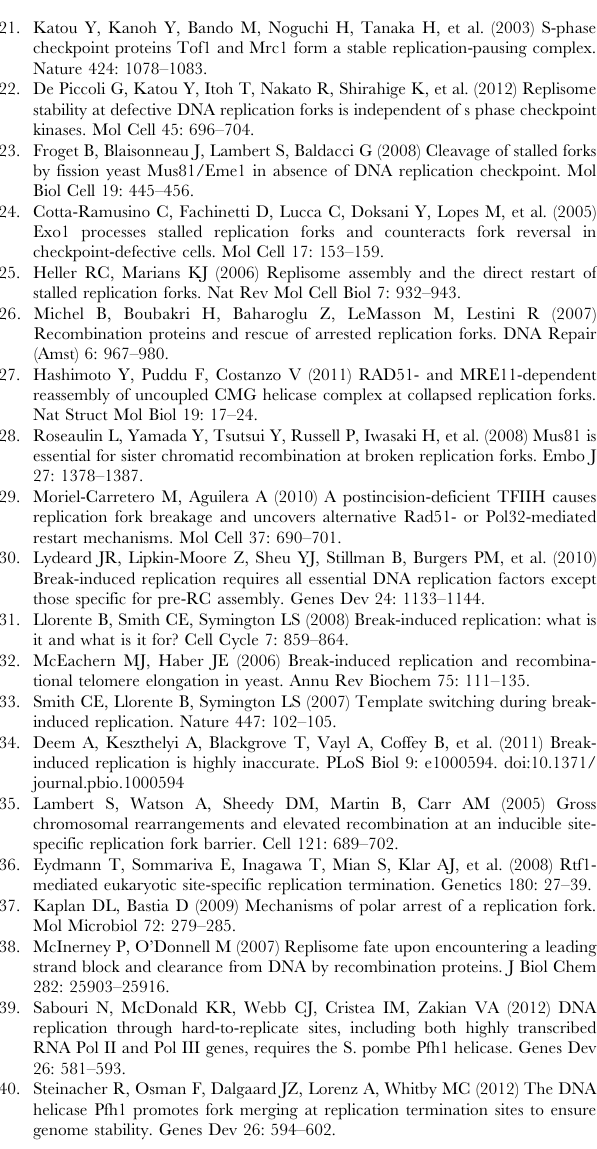
Figure S3 Features of replication slippage induced by fork arrest. A. Table of deletion/duplication and micro-homology features. B. Map of deletion and duplication events observed within the ura4 ORF in the t-ura4 , ori construct upon fork arrest. Del and Dup stand for deletion and duplication, respectively. Figure S4 Sensitivity of rad22-d strain to acute exposure to 20 mM of HU or 20 m M of CPT. The values reported are means of two to four independent experiments. Error bars indicate the standard error of the mean (SEM). Figure S5 Fork-arrest-induced replication slippage is indepen- dent of the post-replication repair and mismatch repair. A–C. Left panels: Serial tenfold-dilutions of indicated strains cultured in thiamine-free medium spotted onto the medium indicated. RTS1 - RFB activity ‘‘–’’ refers to the strain t-ura4-dup20-ori and ‘‘ + ’’ refers to the strain t-ura4-dup20 , ori . Right panels: The frequency of Ura + revertants from the strains indicated ( t-ura4-dup20-ori associated